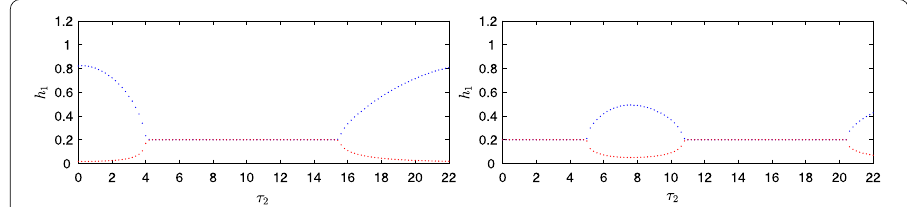
Figure 5 Bifurcation diagram of system (2.2) by regarding τ 2 as bifurcation parameter with parameter values ε = 1, κ = 2, μ = 0.17, d = 0.1, m = 0.05. Left panel: τ 1 = 2; right panel: τ 1 = 6